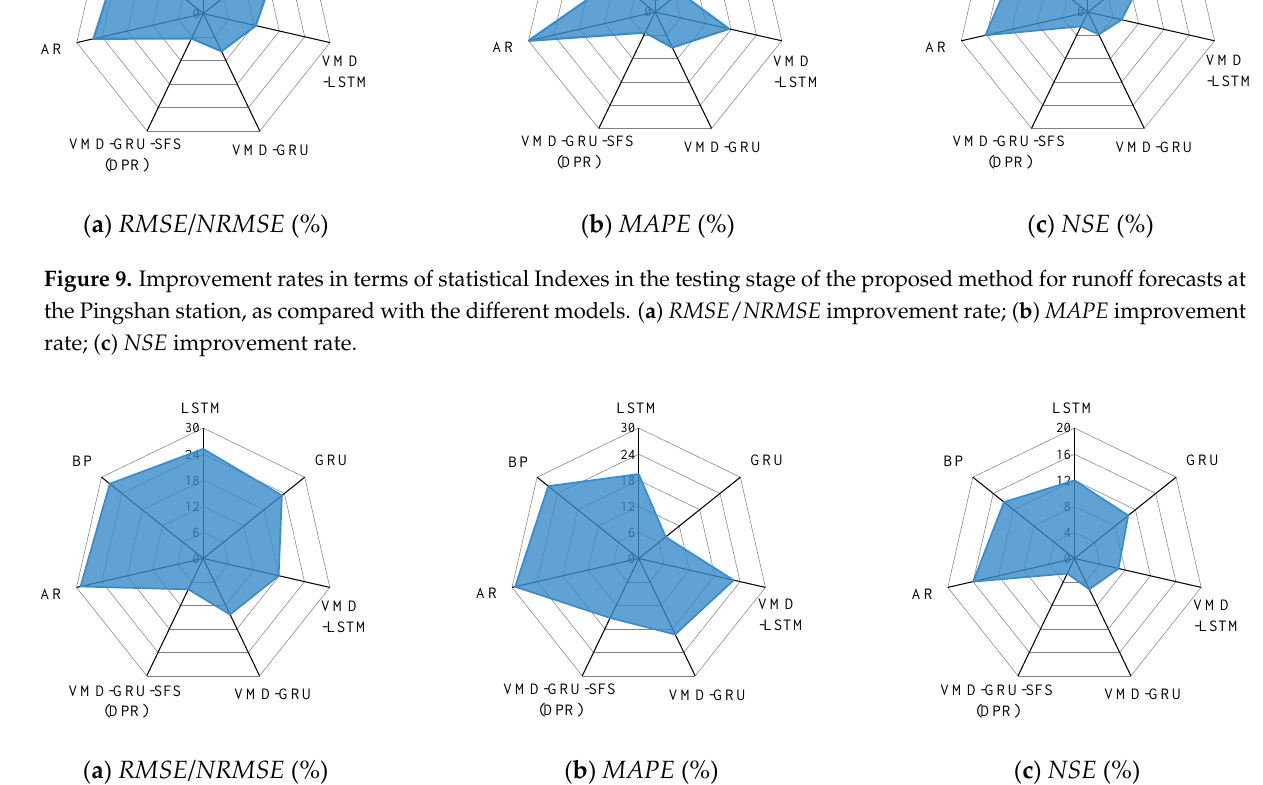
Table 4. Results of different forecasting methods for the Yichang station.